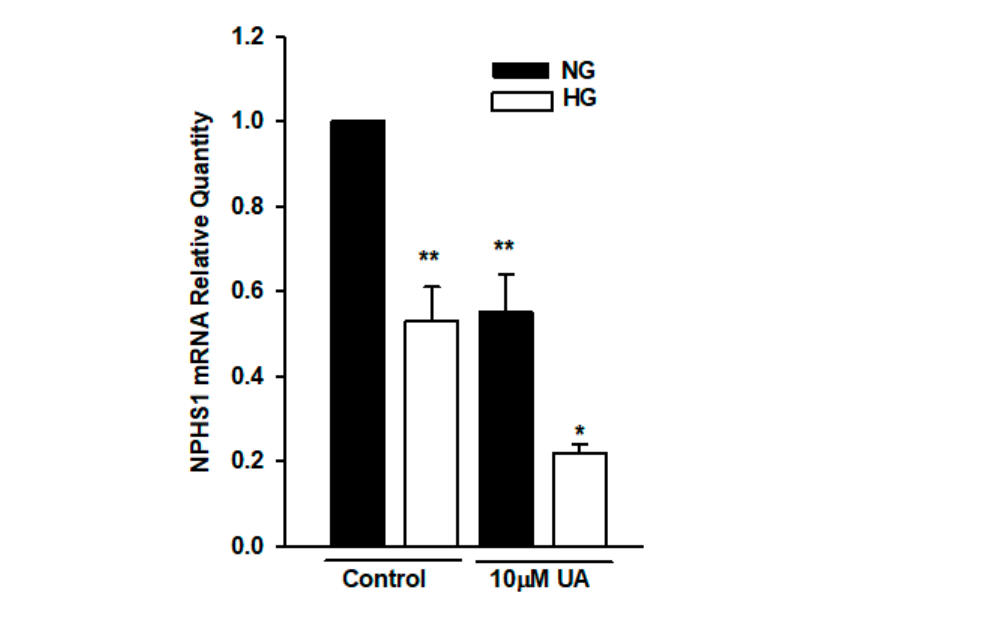
Figure 10. High glucose and UA downregulated the expression of NPHS1 mRNA. Podocytes cultured for 7 d in NG or HG media were incubated for 24 h with 10 µM UA, and total RNA was isolated and analyzed by quantitative RT-PCR. Relative levels of NPHS1 mRNA expression were normalized to β -actin. Each experiment was performed in triplicate, and results are shown as mean ± SEM. The Student’s t -test was used to calculate p values. * p < 0.05 vs. Control HG, ** p < 0.01 vs. Control NG ( n = 3).